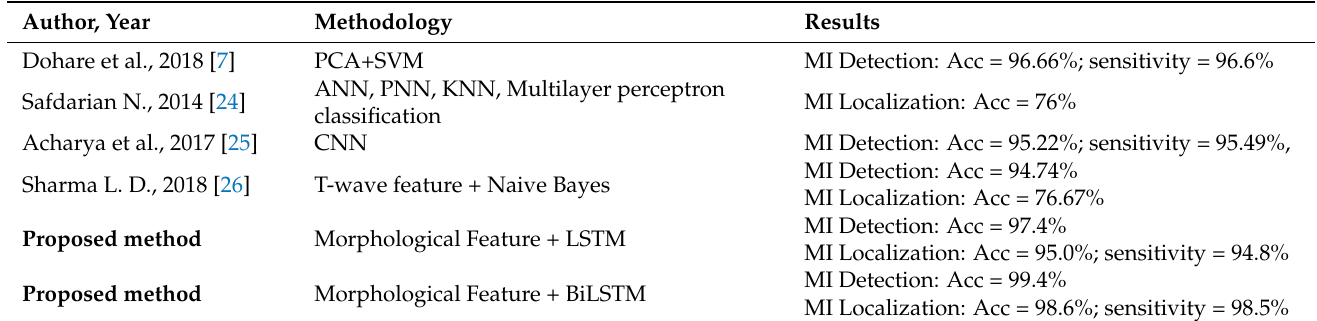
Table 7. Comparison of myocardial infarction recognition